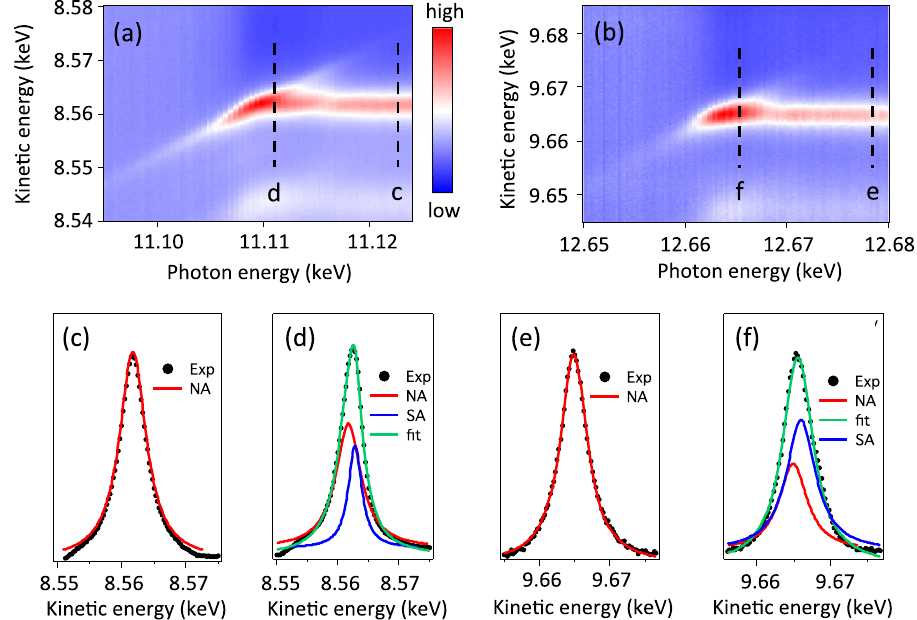
Fig. 4 Resonant Auger photoemission spectra. a Resonant Auger maps of Ge KLL . b Resonant Auger maps of Se KLL . c , d Resonant photoemission spectra of Ge KLL are recorded at the photon energy at 11.123 and 11.111 keV. e , f Resonant photoemission spectra of Se KLL are recorded at the photon energy at 12.678 and 12.665 keV. These excitation energies are indicated by dashed lines in a and b . The experimental spectra are shown in dotted black curves, and they are are fi tted by normal Auger peak (red curves) and spectator Auger peak (blue curves) in c – f